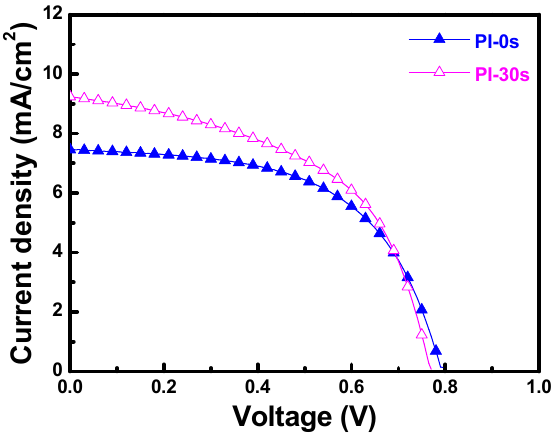
Figure 14. Current–voltage properties of fabricated p-i-n α -Si:H thin-film solar cells.